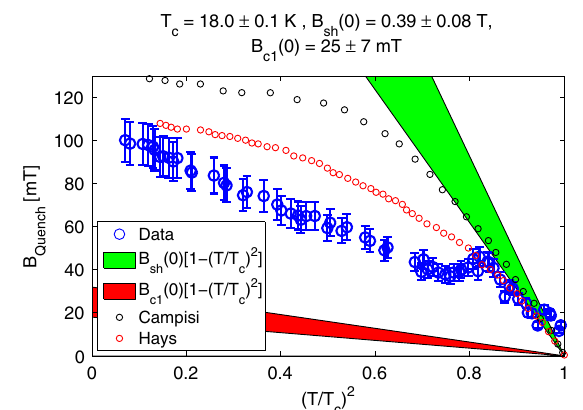
FIG. 14. Quench field as a function of temperature at constant P f .